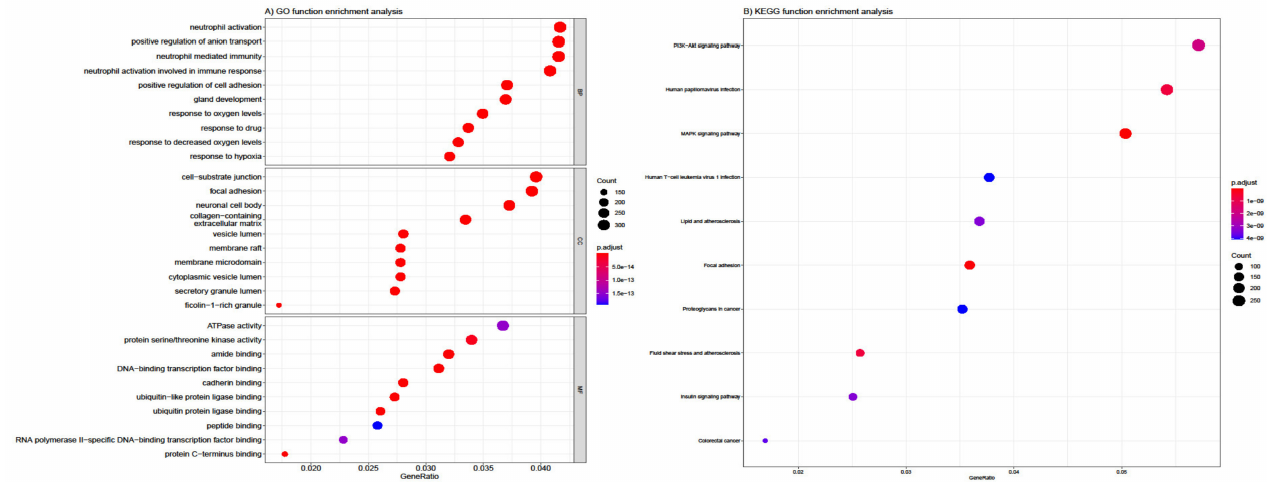
Figure 3. GO ( A ) and KEGG ( B ) function enrichment analysis. The abscissa signifies the number of genes enriched in the